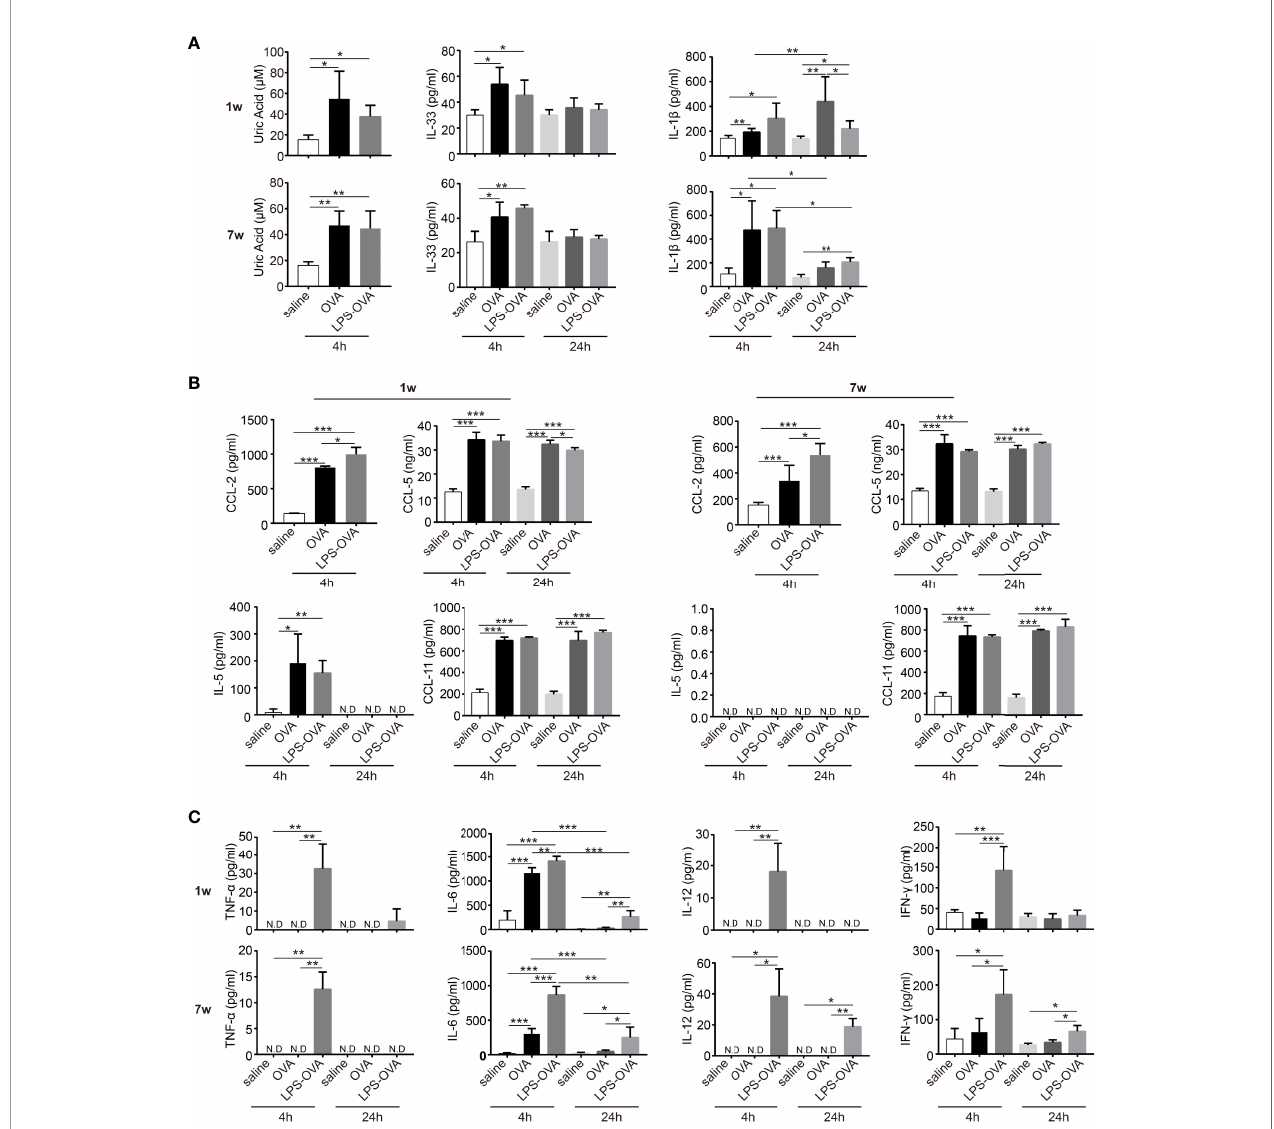
FIGURE 4 | LPS treatment before OVA/alum sensitization affected the microenvironment of peritoneal cavity. (A – C) The peritoneal lavage fl uids (PLF) from LPS/ saline-treated neonatal and adult mice were collected 4 and 24 h after the fi rst OVA/alum sensitization. The levels of alarmins (uric acid, IL-33, and IL-1 b ) (A) , chemokines (CCL-2, CCL-5, IL-5, and CCL-11) (B) , and cytokines (TNF- a , IL-6, IL-12, and IFN- g ) (C) in the PLF were determined by ELISA. Mouse experiments were performed three times and data are pooled from the analysis of two litters ( n = 8 mice per group). Data are the means ± SD. * P < 0.05, ** P < 0.01, *** P < 0.001. ND, not